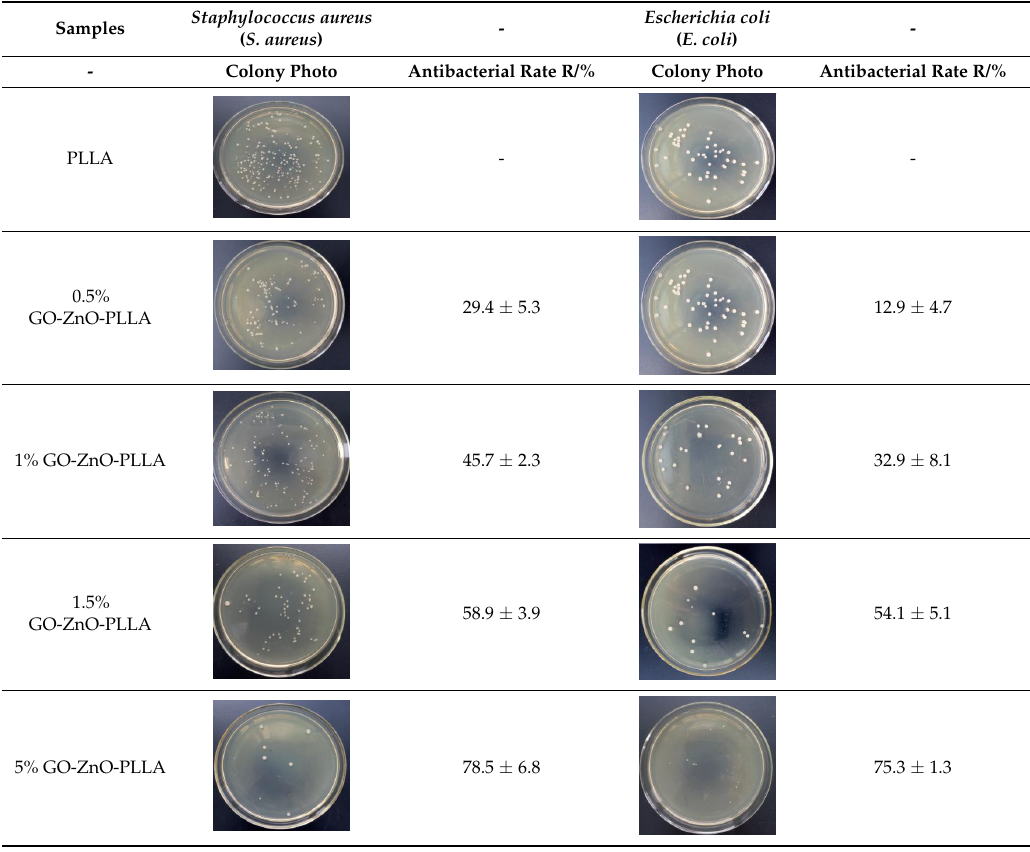
Table 4. Test results of the antibacterial properties of GO-ZnO-PLLA/PLLA composite film without light exposure.